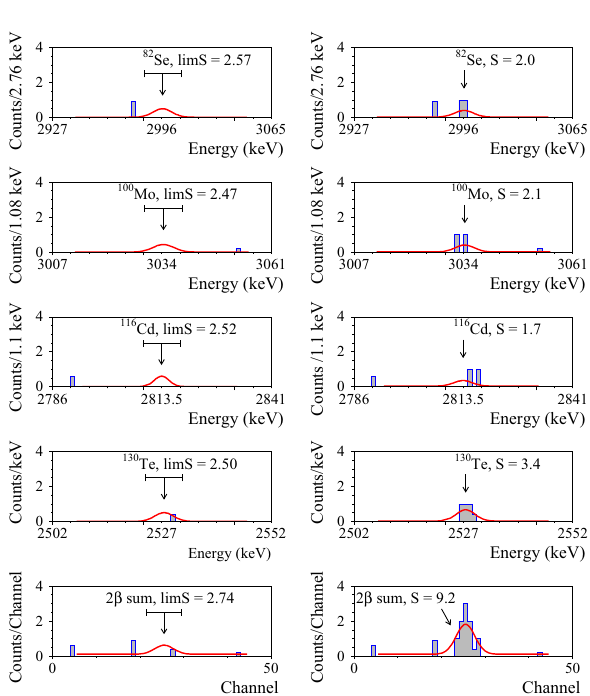
Fig. 4 Generated energy spectra for Zn 82 Se, Li 100 MoO 4 , 116 CdWO 4 2 and 130 TeO 2 detectors for the CUPID-1 option, assuming a level of Fig. 5 Generated energy spectra for Zn 82 Se, Li 100 MoO 4 , 116 CdWO 4 background of 4 × 10 − 6 counts/yr/keV/kg. The figures at the left col- 2 and 130 TeO 2 detectors for the CUPID-4 option and sum energy spectra, umn show the “no effect observed” case. The energy intervals where the assuming a level of background of 4 × 10 − 6 counts/yr/keV/kg. The numbers of background counts N BG were estimated (the N BG values figuresattheleftcolumnshowthe“noeffectobserved”case.Theenergy are given in Table 4) are shown. The figures at the right column illus- intervals where the numbers of background counts N BG were estimated trate effects for a neutrino mass of 0.02 eV calculated with the matrix (the N BG values are given in Table 5) are shown. The figures at the right elements from Ref. [46], the phase space factors from Ref. [47] and column illustrate effects for a neutrino mass of 0.02 eV calculated with the value of the axial vector coupling constant g A = 1 . 27. Values of the matrix elements from Ref. [46], the phase space factors from Ref. excluded lim S and peaks areas S are in counts [47] and the value of the axial vector coupling constant g A = 1 . 27. Values of excluded lim S and peaks areas S are in counts